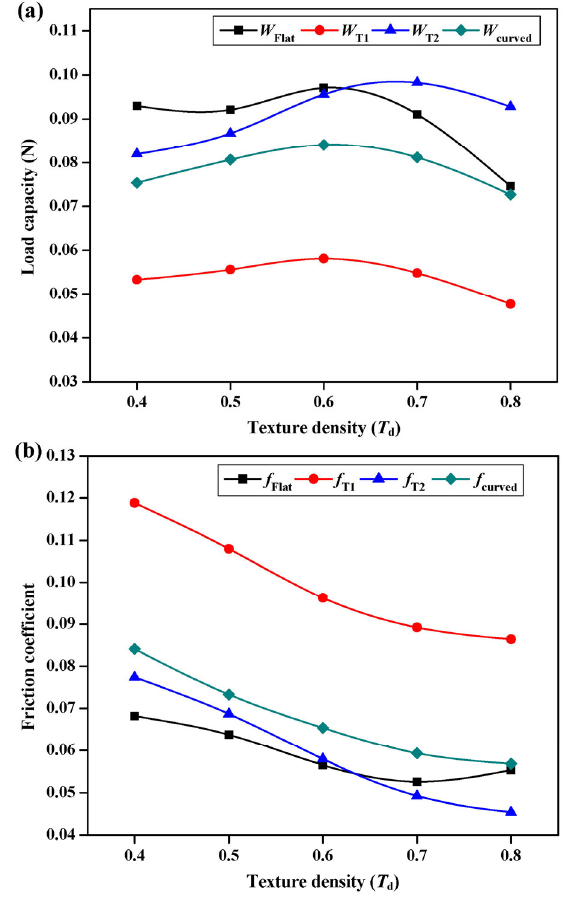
Fig. 7 Effect of aspect ratio on (a) load capacity and (b) friction coefficient.